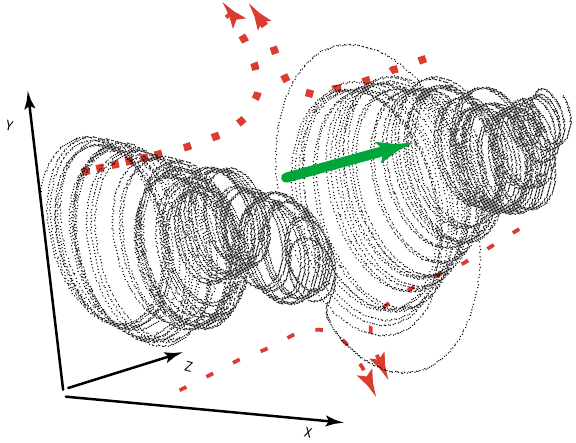
FIG. 4. (Color) X , Y vs z particle motion in the single flip chan- nel. The dashed lines indicate magnetic field lines and the loca- tion of the change in field polarity. In the first half of the cooling channel the transverse momentum and therefore the radius of the Larmor motion decreases, but the distance of the Larmor center from the beam axis changes only due to multiple Coulomb scat- tering. In the second half, the Larmor center coincides with the beam axis, and the radius of the Larmor motion decreases with the transverse